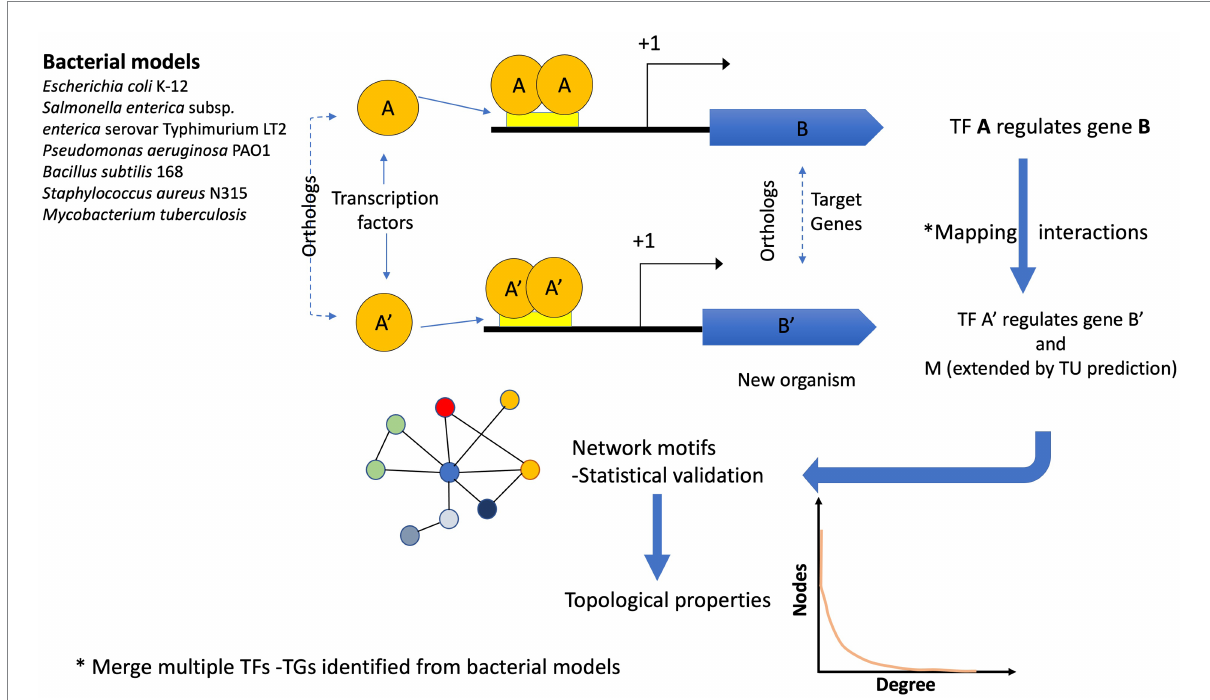
FIGURE 1 Flux diagram showing the inference of the GRNs. Six bacterial models were used to infer the GRNs in 12,230 bacterial and 649 archaeal genomes. If the pair A (TF) – B (TG) in a reference genome is identified (by orthology) in a new genome A ′ (TF) –B ′ (TG), the interaction is assigned. In addition, if the TG identified in the new genome is the first one in the TU, the interaction is extended to the other gene(s). One interaction in a new genome can be derived from one or more bacterial models. Finally, the reconstructed networks were evaluated in terms of their topological